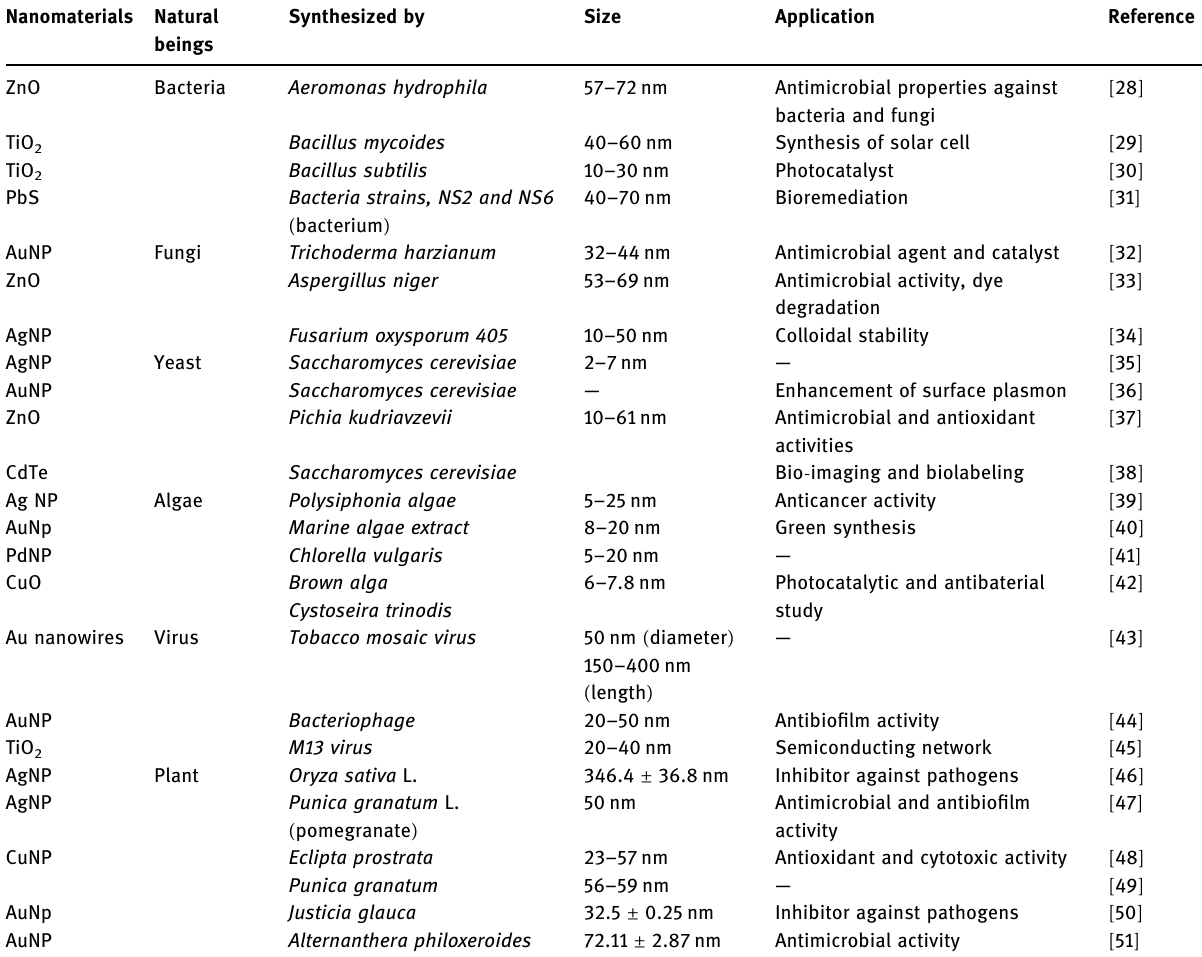
Table 1: Various green nanomaterial and their applications Nanomaterials